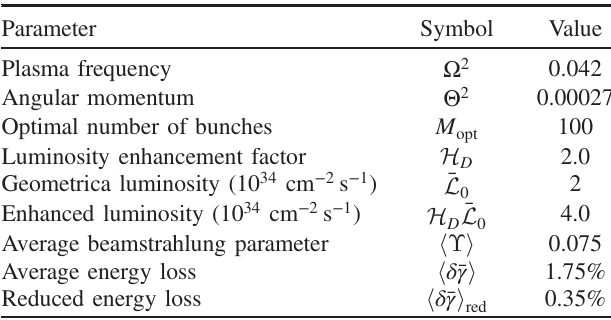
TABLE IV. Summary of luminosity enhancement and corre- sponding energy loss for the two test cases of Table